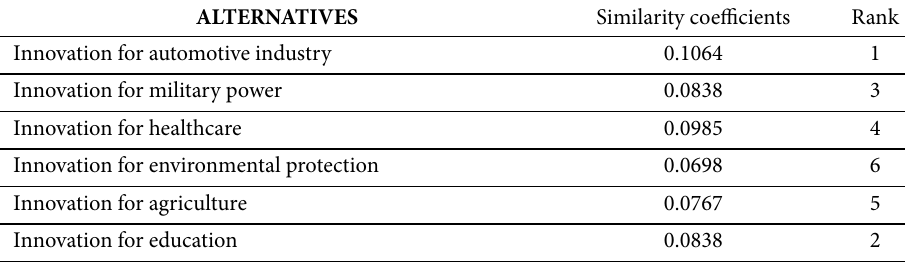
Table 8. Similarity coefficients to ideal solutions and ranks of alternatives